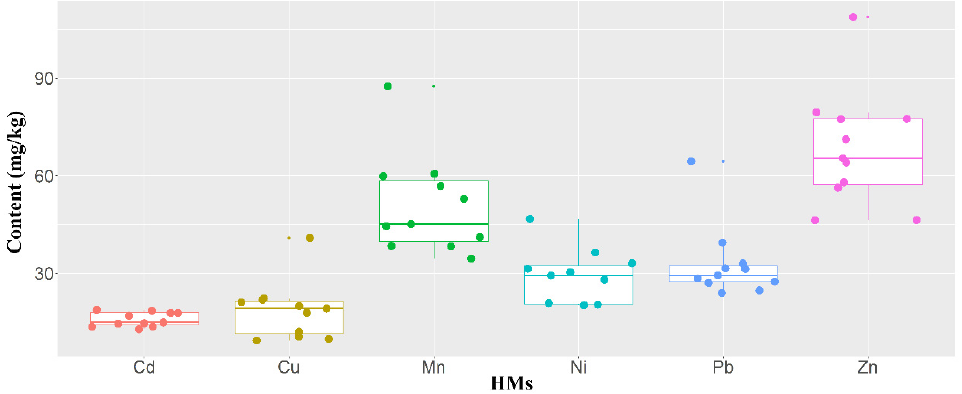
Figure 2. HM content in the Henan section of the Yellow River. The Cd content was multiplied by 100 and the Mn content was divided by 10 to facilitate the visualization of the HM content.